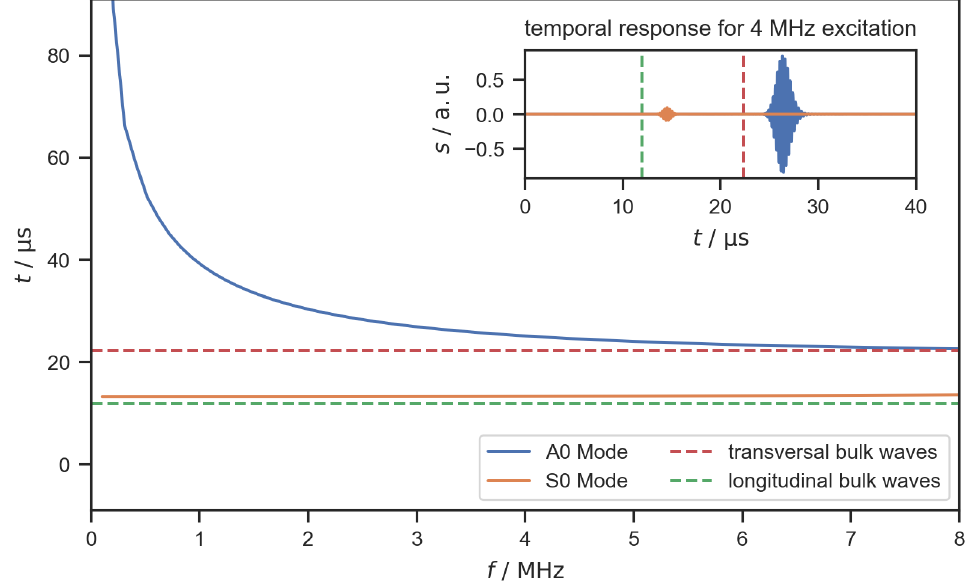
Figure 2. Propagation times of A 0 and S 0 modes and bulk wave for a distance of 68 mm on a flat stainless steel plate (thickness 0.1 mm) calculated with the Dispersion Calculator [38]. The inset shows the calculated out-of-plane amplitude of the temporal guided wave responses for a 4 MHz sinusoidal excitation signal (ten cycles, Gaussian